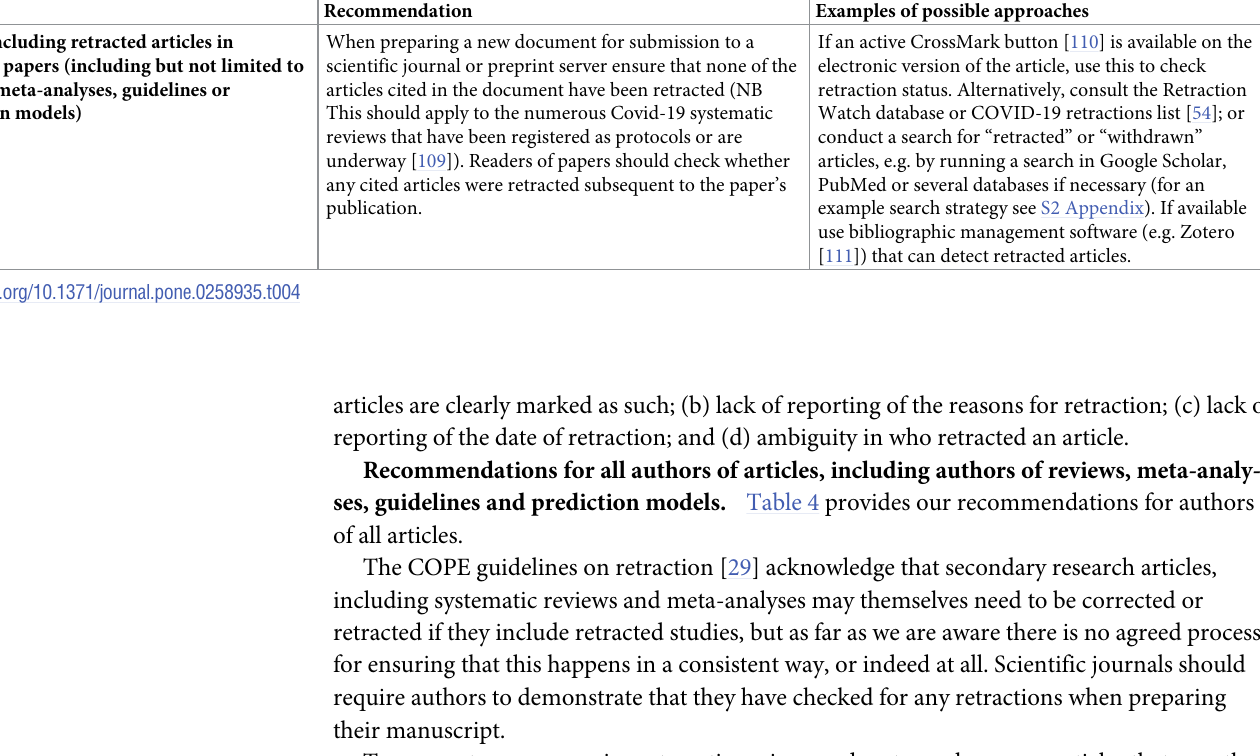
Table 4. Recommendations for authors of all articles, including (but not limited to) authors of reviews, meta-analyses, guidelines and prediction models.